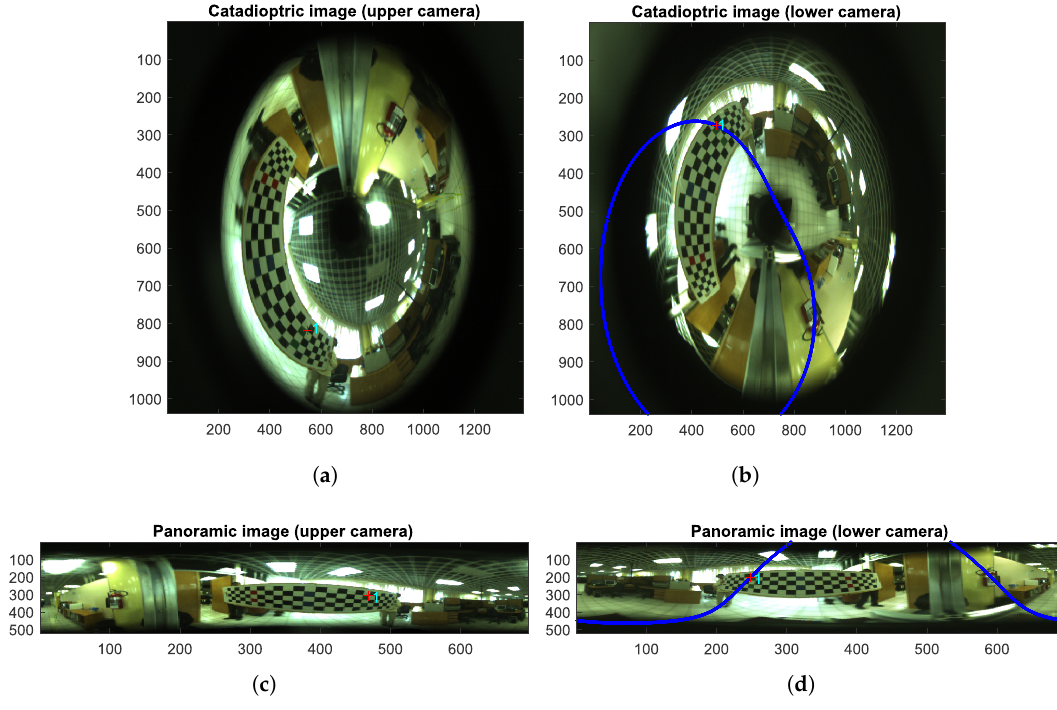
Figure 5. Feature point and epipolar curve (best seen in color). ( a ) Feature point (red mark) in the upper catadioptric image, ( b ) Feature point (red mark) and epipolar curve in the lower catadioptric image, ( c ) Feature point (red mark) in the upper panoramic image, ( d ) Feature point (red mark) and epipolar curve in the lower panoramic